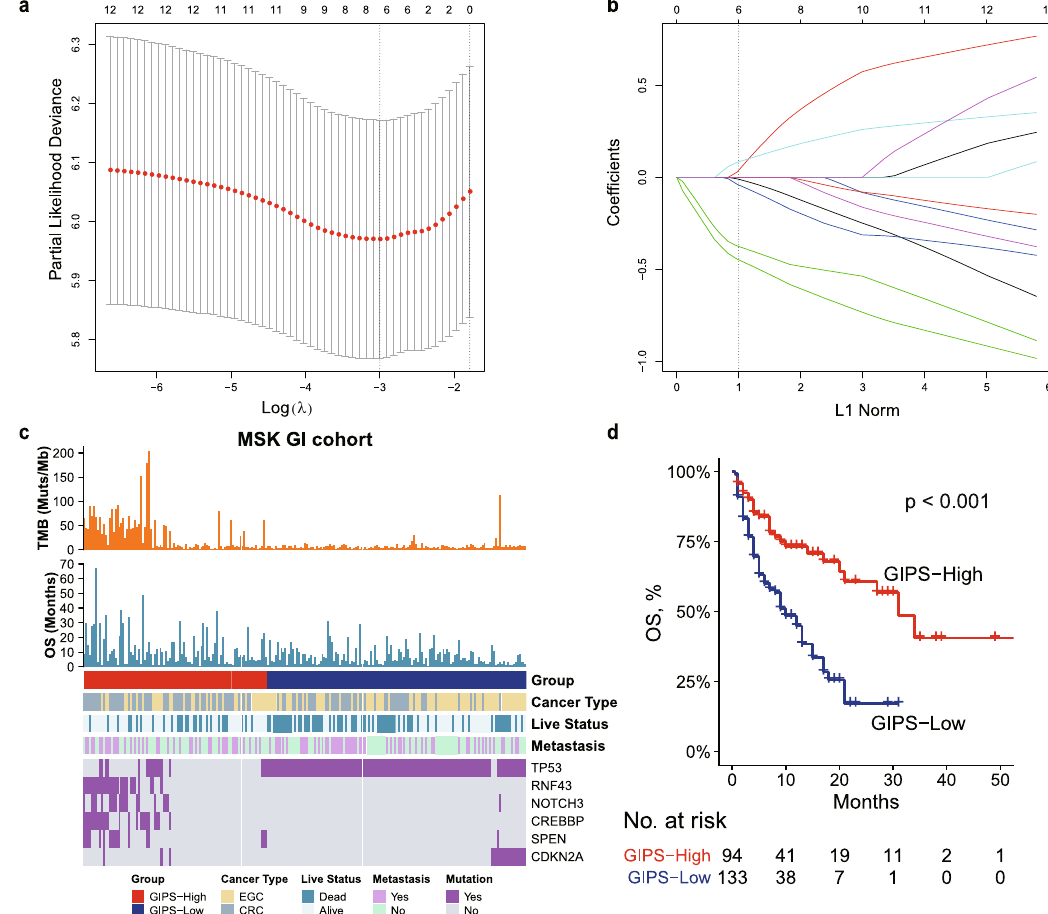
Fig. 1 Construction of GIPS. a Tenfold cross-validation for selection of tuning parameters in the LASSO regression. Two dotted vertical lines are drawn at the optimal values according to the minimum criterion (right) and the 1 − SE criterion (left). b LASSO coef fi cient pro fi les of the 12 candidate genes. The dotted vertical line indicates the optimal value (L1 Norm = 1), which was identi fi ed by tenfold cross-validation. c Heatmap of the clinical and molecular features associated with the GIPS-high and GIPS-low subgroups in the MSK-GI cohort. d Kaplan – Meier curves of OS for patients with high and low GIPS scores in the MSK-GI